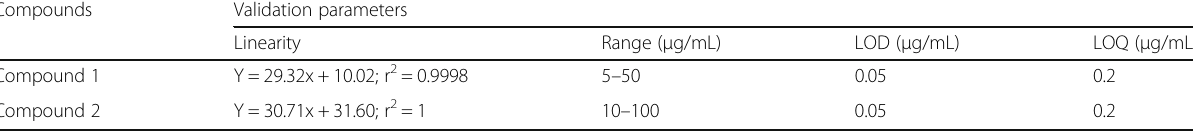
Table 4 Linearity, range, LOD and LOQ of compound 1 and compound 2 Compounds